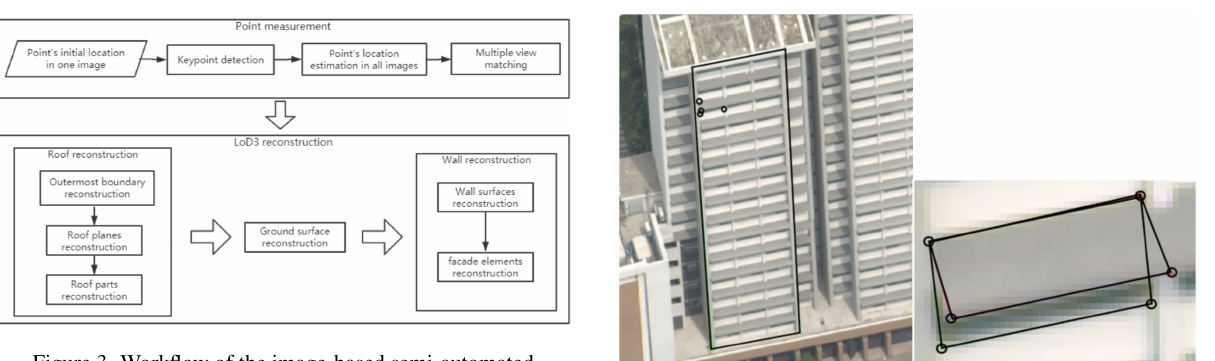
Figure 3. Workflow of the image-based semi-automated geometric building model reconstruction